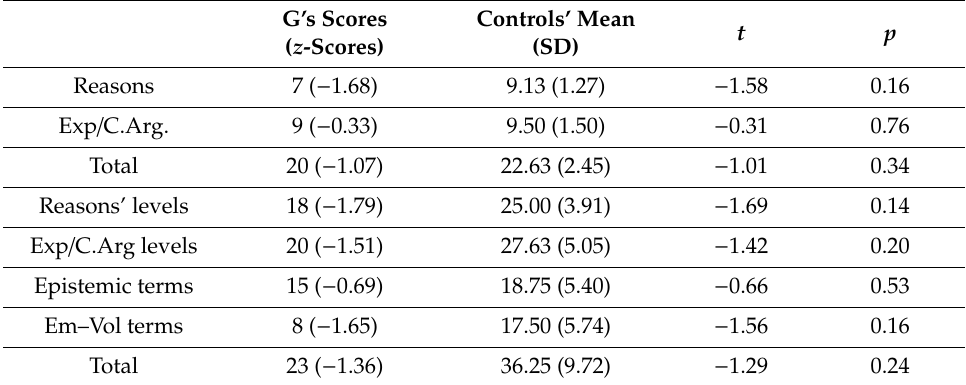
Table 2. Comparisons between G and control